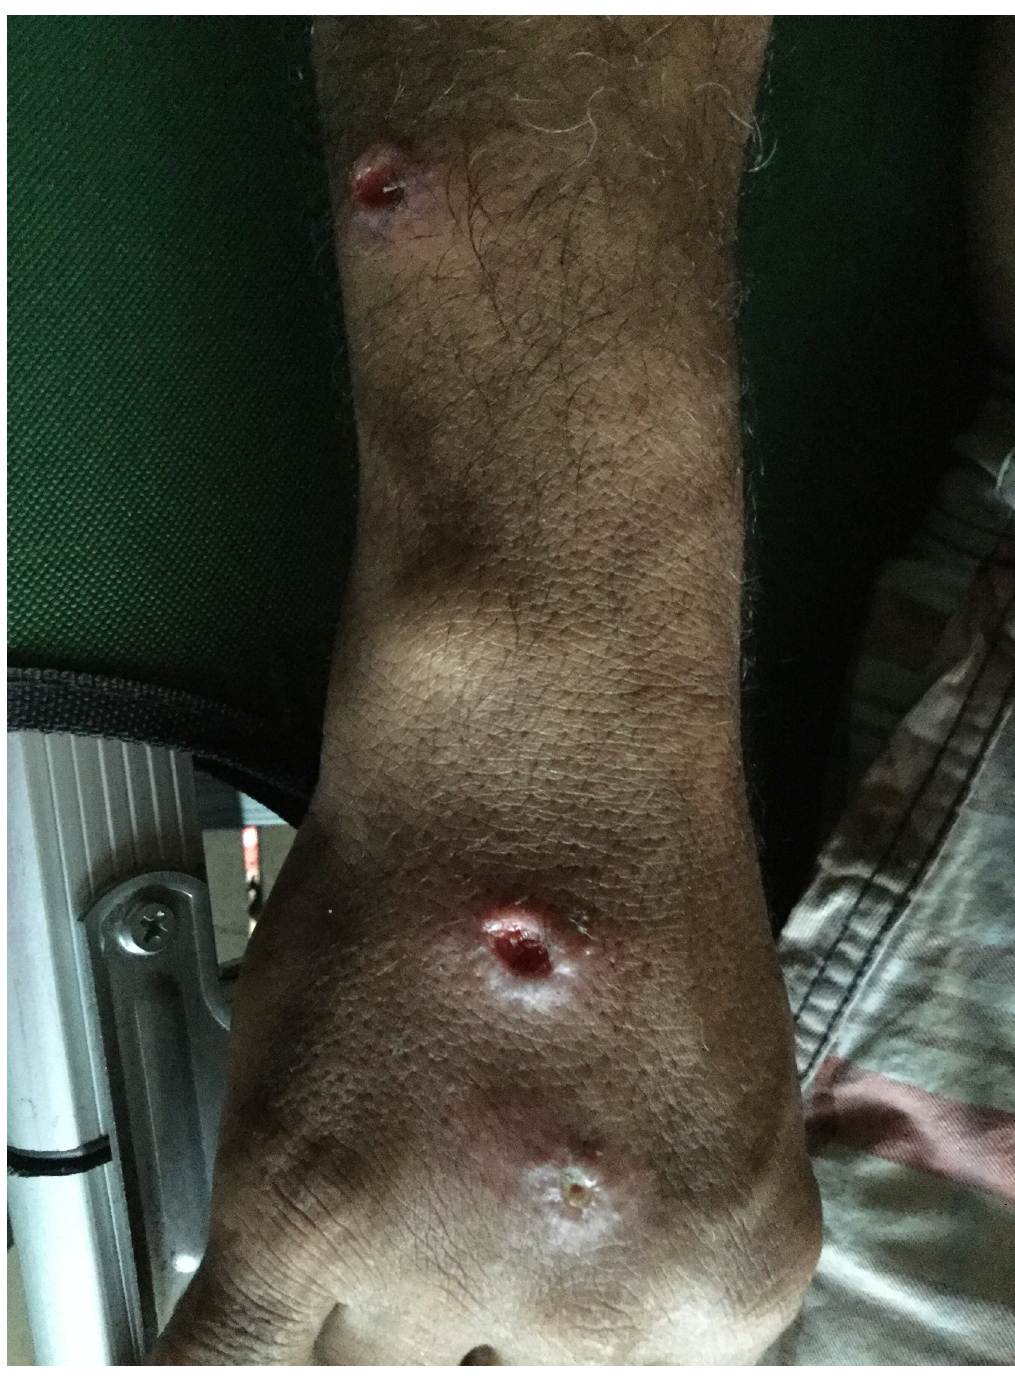
Fig 2. Three cutaneous leishmaniasis lesions on a gold miner included in the 2019 study. Among the three samples of the ulcerated lesions for PCR, one was negative, one was posi- tive for L . guyanensis , and one was positive without enough amplification to identify the infect- ing species. Among these nine persons with active leishmaniosis lesions, five reported to have used a pentamidine injection at least once (up to four times) during the previous year: three